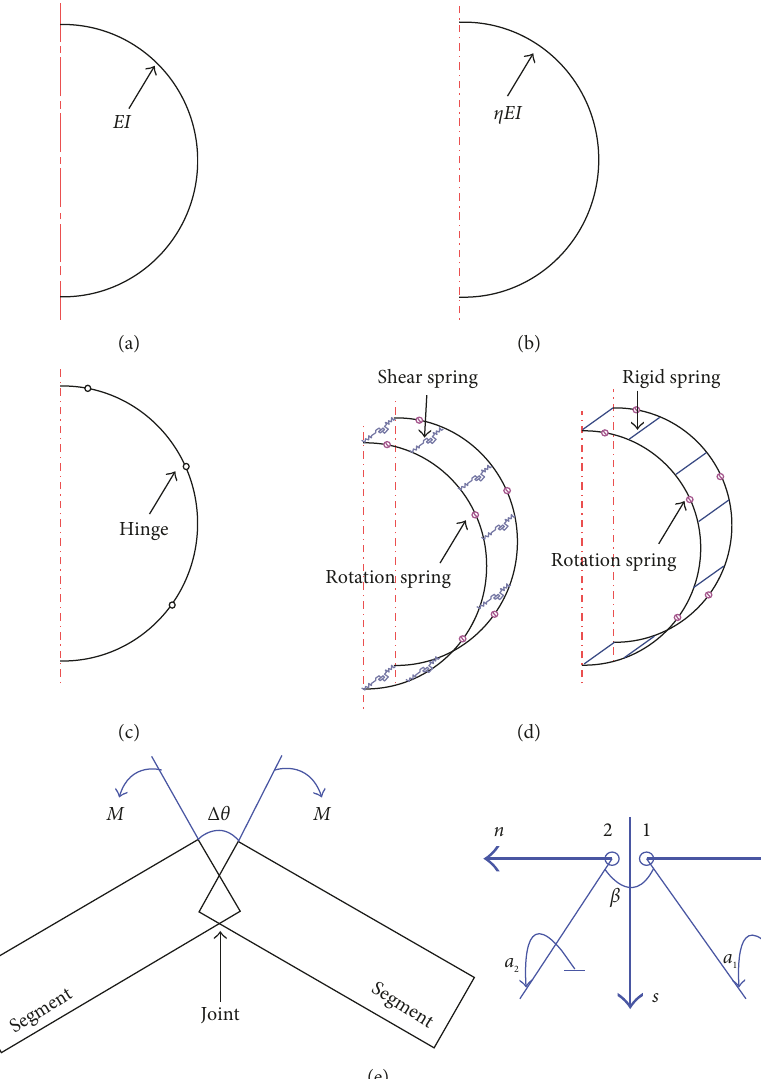
Figure 1: Structural models of the shield segment [7]. (a) UR model. (b) MUR model. (c) Free hinge ring model. (d) Beam-spring model. (e) Beam-joint